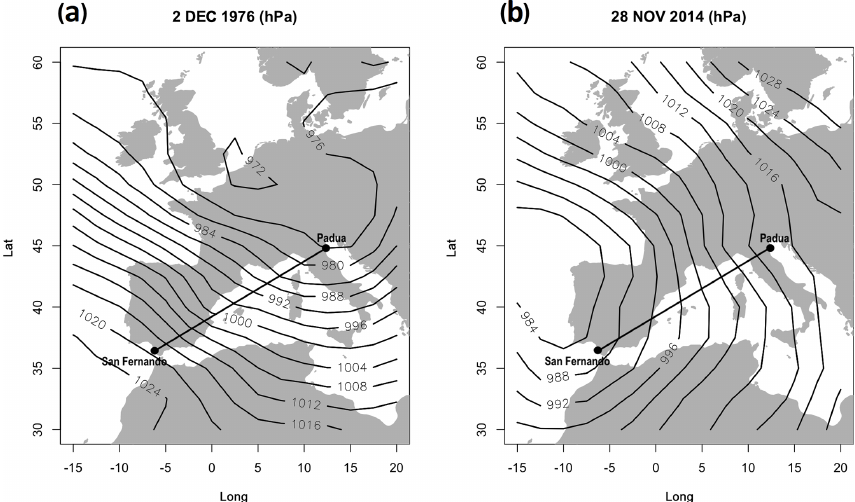
Figure 3. (a) Most extreme positive phase of the Western Mediterranean Oscillation (WeMO) in a daily synoptic situation during the 1951– 2016 study period (2 December 1976). (b) Most extreme negative WeMO phase in a daily synoptic situation during the 1951–2016 study period (28 November 2014). Data source: NCEP Reanalysis data provided by the NOAA/OAR/ESRL PSD, Boulder, Colorado,